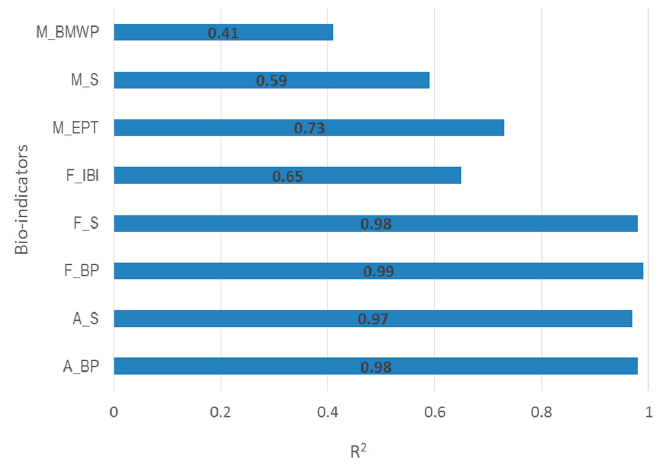
Figure 3. Squared correlation coefficient (R 2 ) values for SVM (support vector machine) models performance.